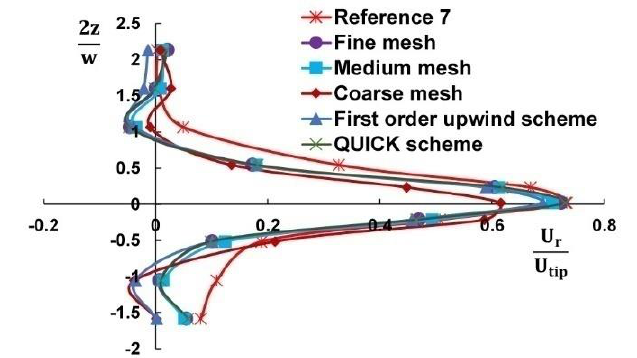
𝑈 𝑟 ⁄ close to the 𝑈 𝑡𝑖𝑝